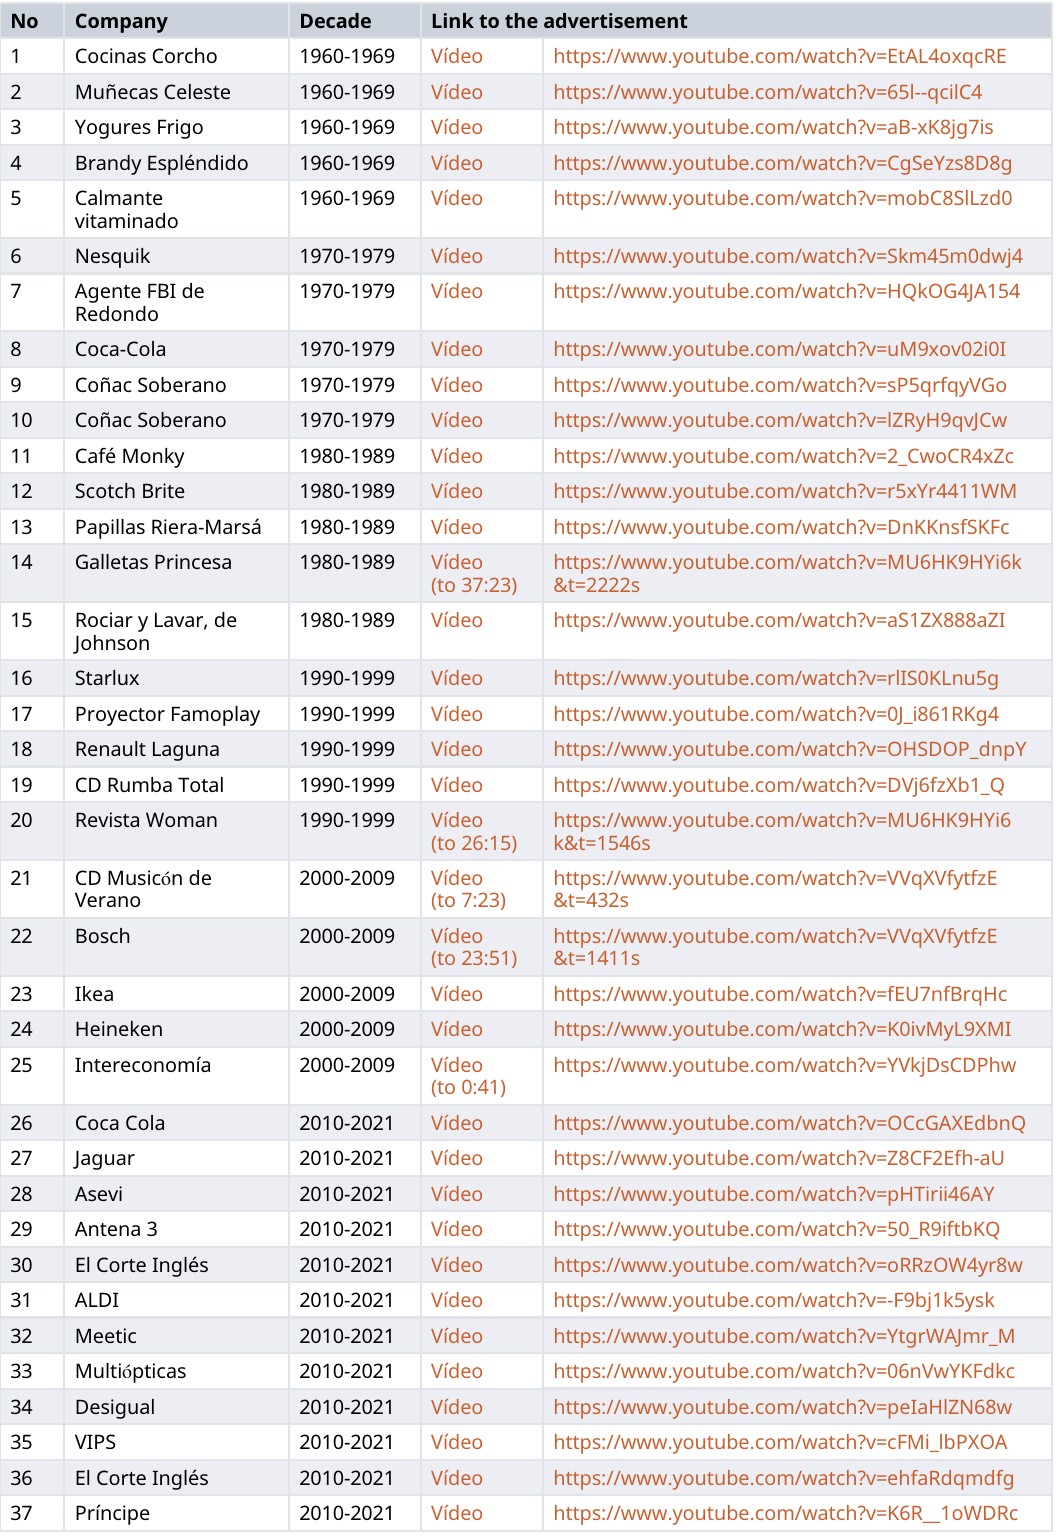
Table 2. List of advertisements